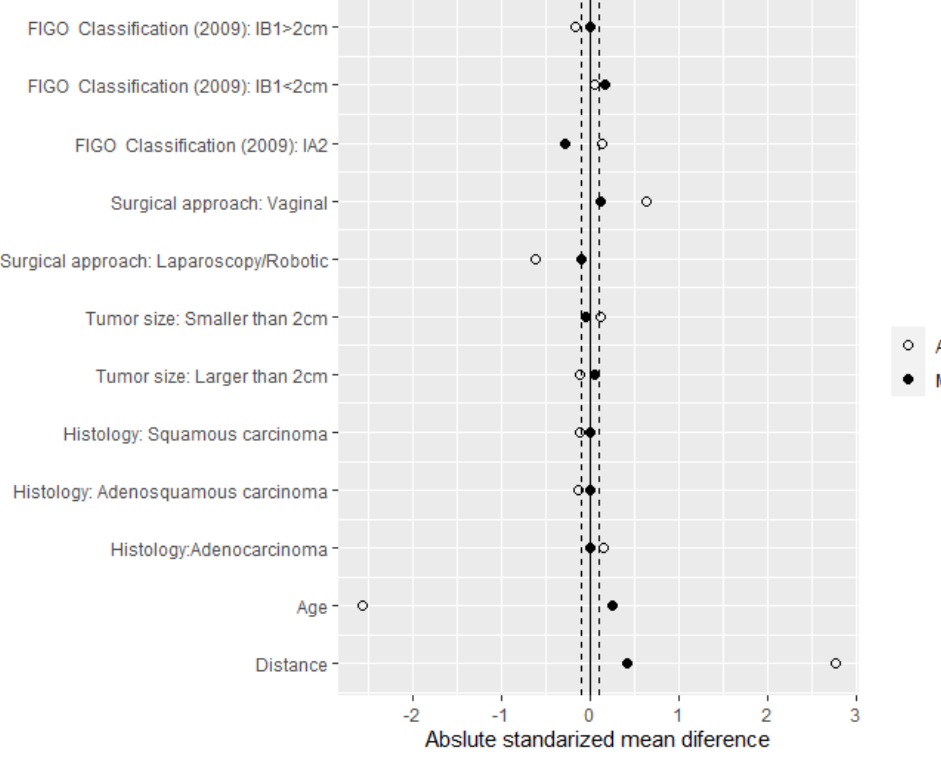
Figure 2. Love plot to visualise the goodness of the match.